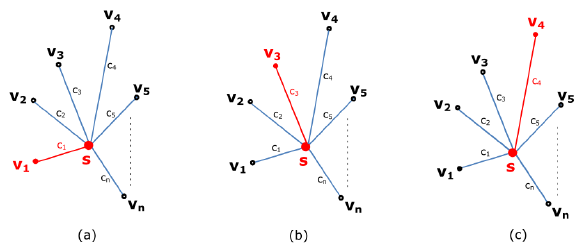
Figure 3. The BT-Graph of a dynamicsensor fiel in three di˙erentconnections(solidred lines) at times t 1 , t 2 and t 3 .